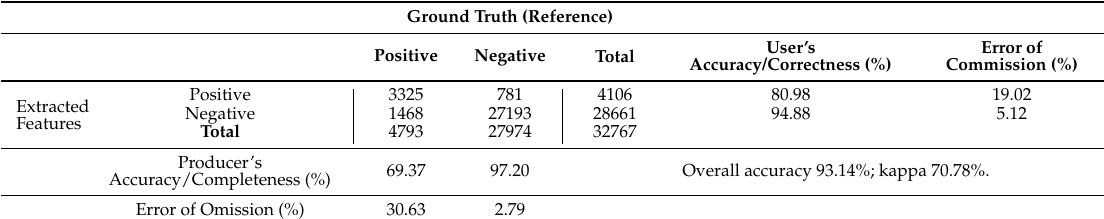
Table 3. Confusion (error) matrix for assessing the quality of extracted landslide scarps based on the topographic surface slope approach.